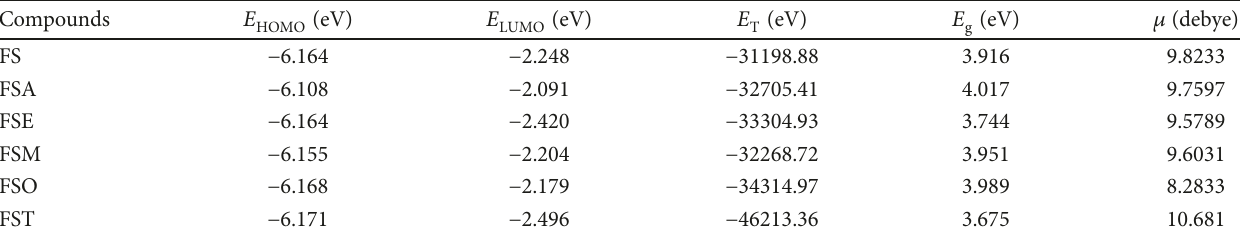
Figure 2: Optimized geometries of the studied molecules in a solvent Table 1: Electrical and optical parameters for all studied compounds obtained in a solvent phase. Compounds